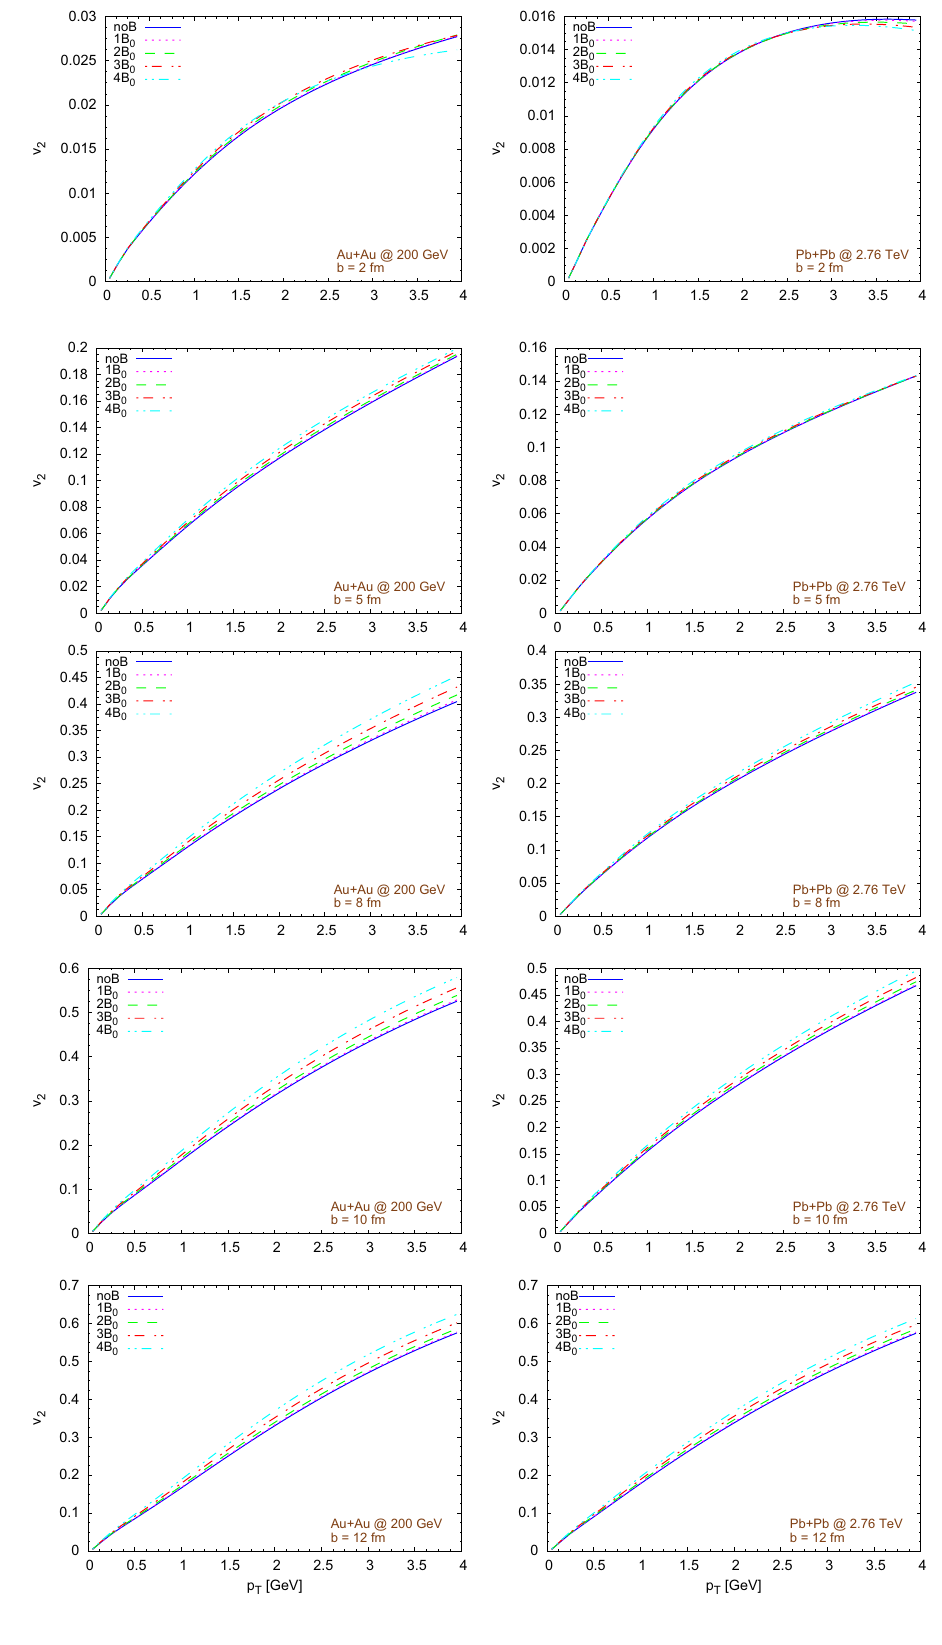
Fig. 2 Elliptic flow of pions for various magnetic field strengths B as a function of the transverse momentum p T . The impact parameter b increases from the top to bottom row. Left: Au+Au √ s NN = 200GeV. collisions at Right: Pb+Pb collisions at √ s NN = 2 .